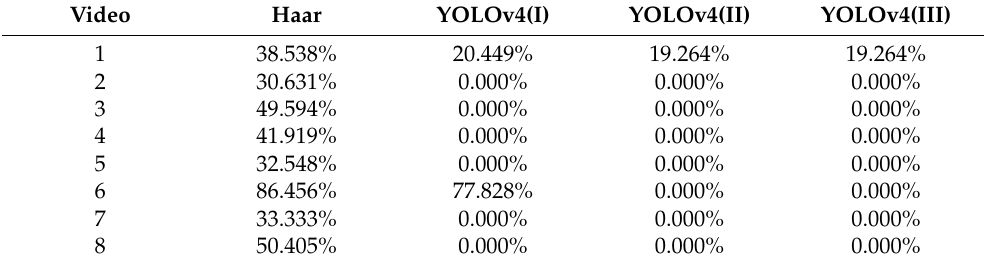
Table 3. False omission rate.